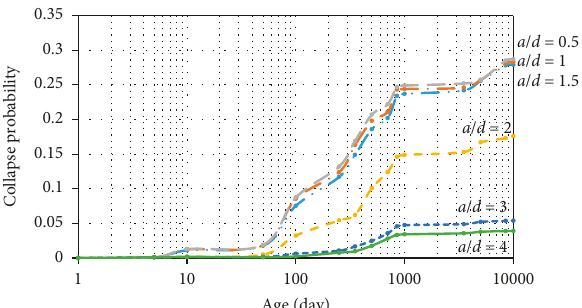
Figure 9: Collapse probability of RC beams in the strength limit state at the load level of P